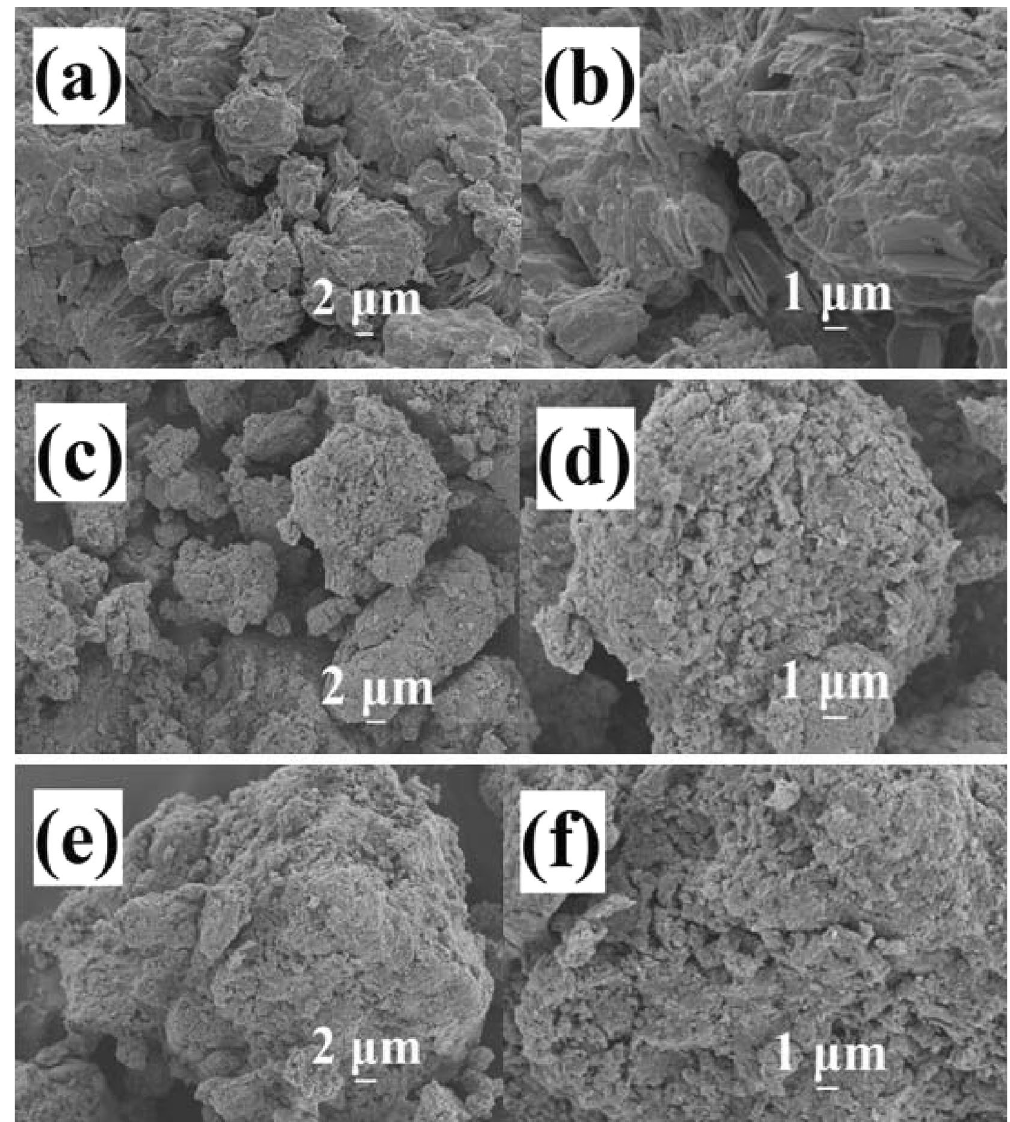
Figure 5. SEM images of the samples synthesized at 60 °C with different concentrations of ZnCl 2 : ( a , b ) 60%; ( c , d ) 65%; ( e , f ) 70%,